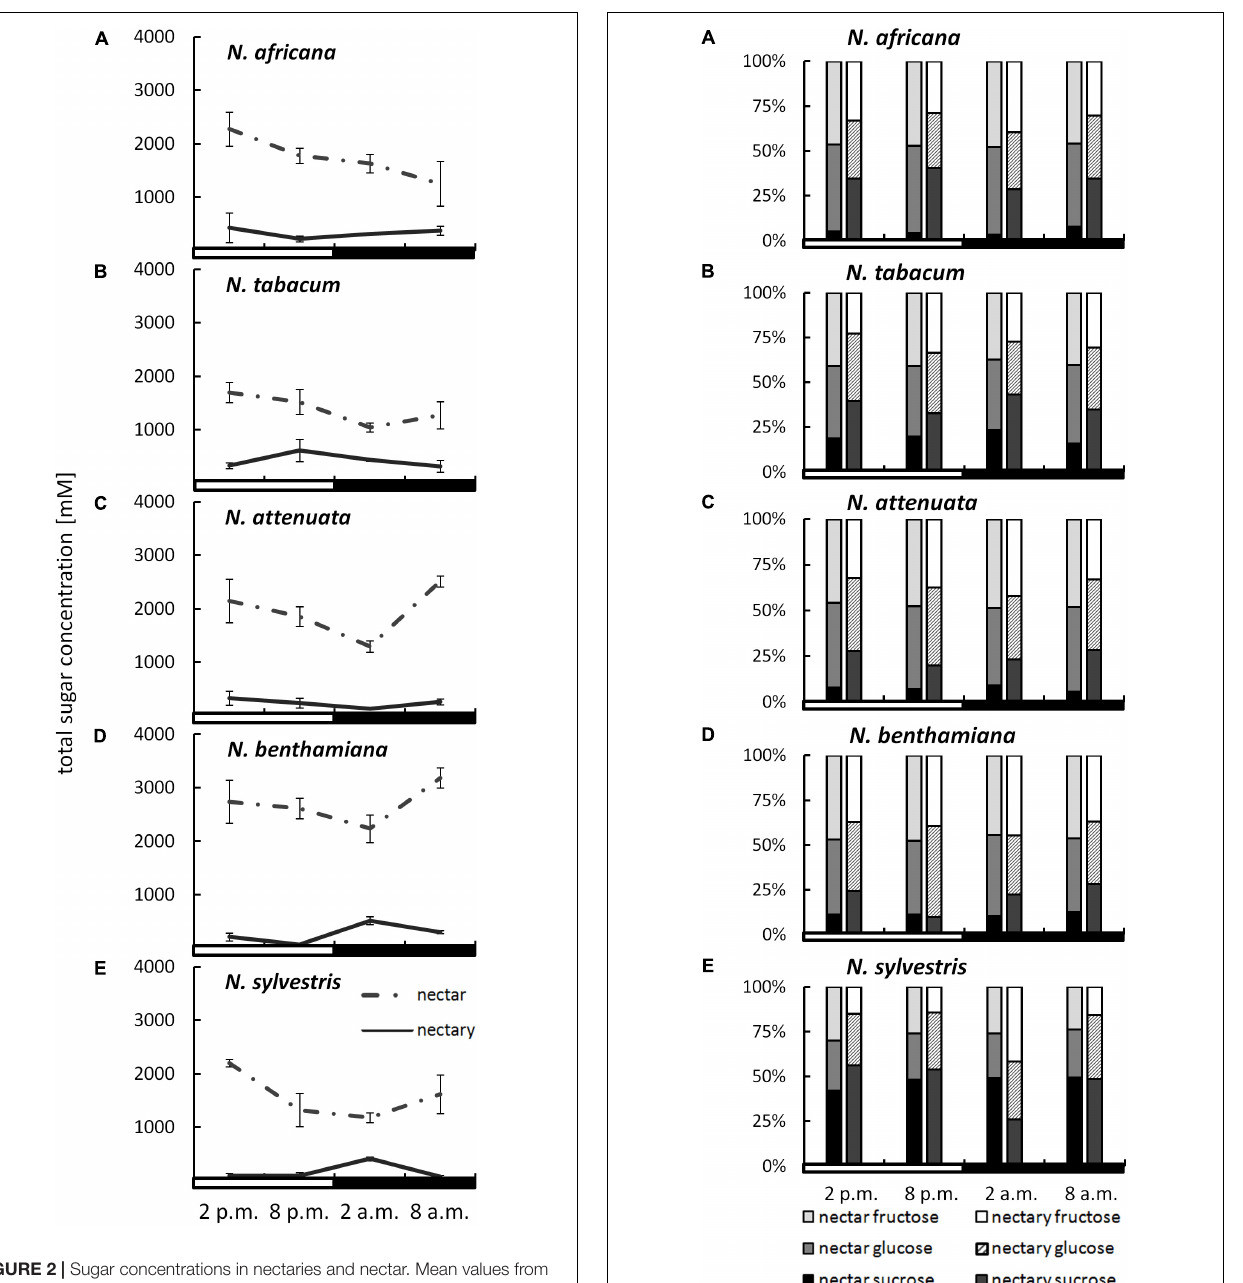
FIGURE 2 | Sugar concentrations in nectaries and nectar. Mean values from all measurements taken at one time point ( n = 3) and the respective SDs were plotted; light and dark periods are indicated by white and black bars. (A) N. africana , (B) N. tabacum , (C) N. attenuata , (D) N. benthamiana , and (E) N. sylvestris .